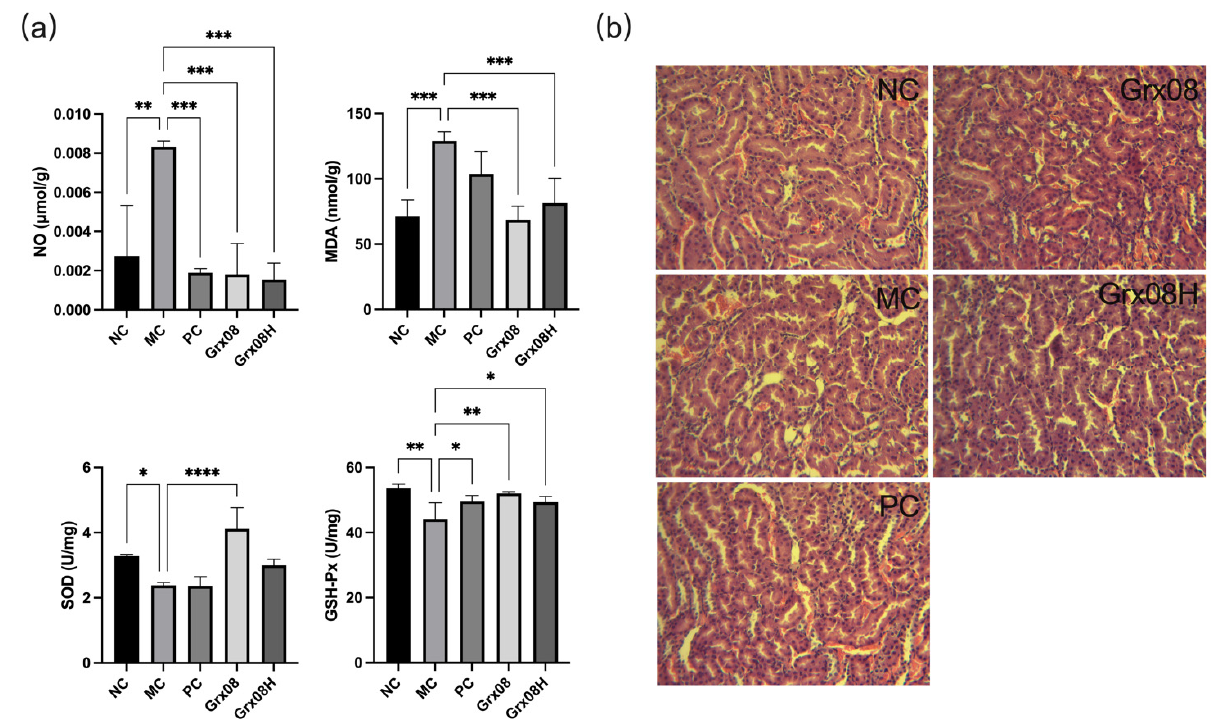
Figure 4. Effect of probiotics on anti-oxidative stress of rat kidney ( n = 5). ( a ) Oxidative damage and antioxidant enzymes activity in rat kidney. ( b ) Case study of rat kidney ( × 200). * indicates a significant difference between groups ( p < 0.05), ** indicates a significant difference between groups (p < 0.01), *** indicates a significant difference between groups ( p < 0.001), **** indicates a significant difference between groups ( p <